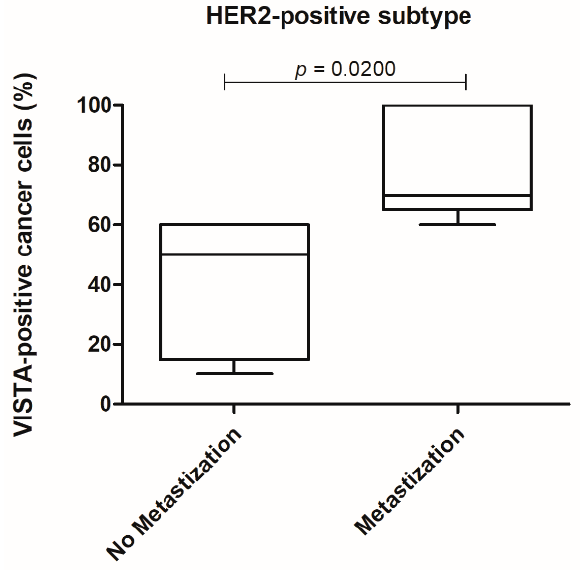
Figure 8. In the HER2-positive tumor subtype a higher VISTA expression in cancer cells was associated with the presence of metastasis (* p = 0.0200).